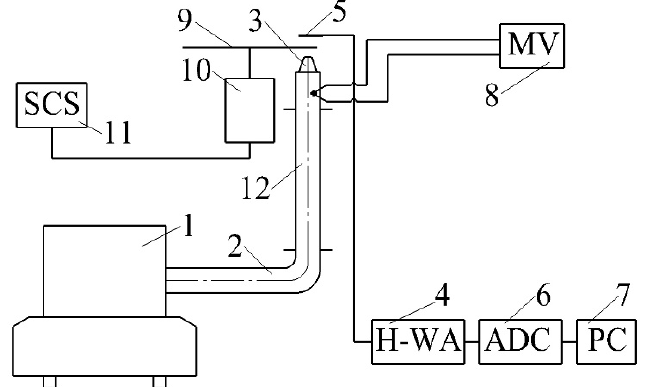
Figure 4. Installation diagram for evaluating the speed of the measuring system (hot-wire anemom- eter with a sensitive element of the sensor): 1—air blower; 2—air supply channel; 3—nozzle; 4—hot- wire anemometer; 5—sensitive element of the sensor; 6—analog-to-digital converter; 7—personal